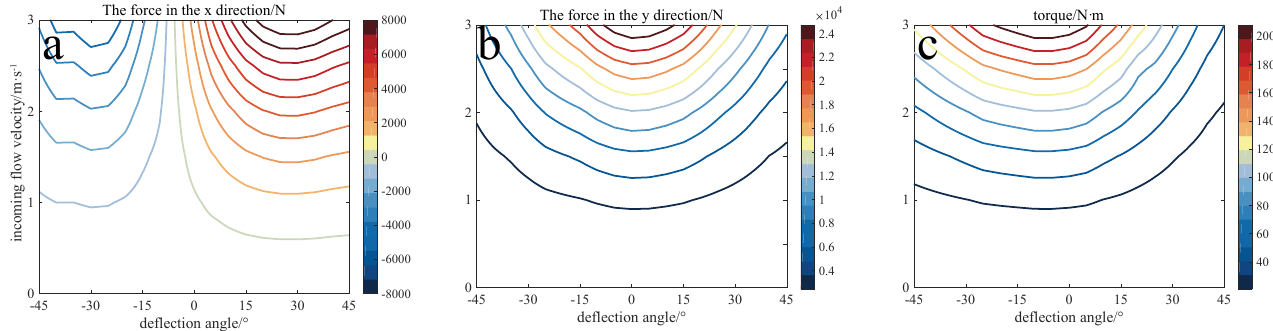
Figure 5. The force of the wings when airfoil is NACA 0012: ( a ) The force in the x direction, ( b ) The force in the y direction, ( c ) torque.